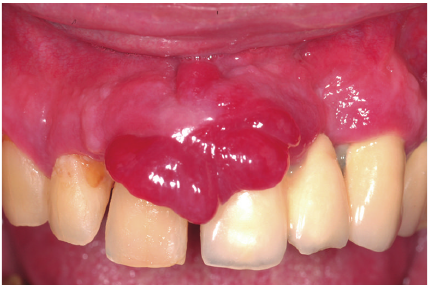
Figure 1: Clinical presentation: a 2,5 cm red nodule, pedunculated, located on the gingival between upper central incisors.